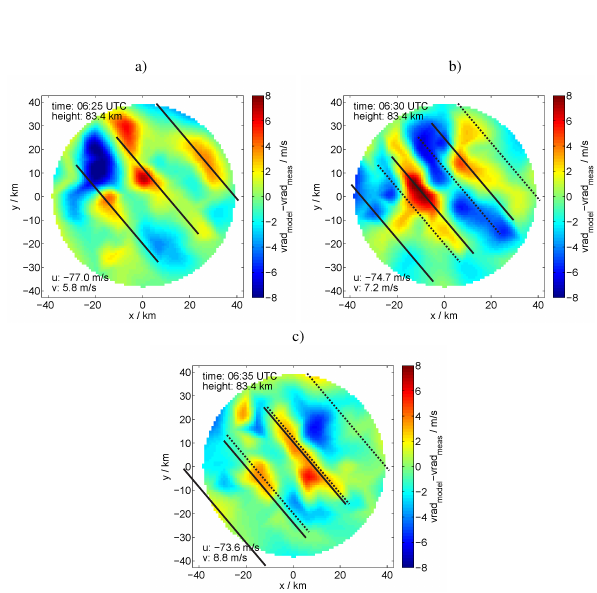
Fig. 11. Remaining horizontally resolved radial wind variation images indicating a dominating monochromatic gravity wave over a period of 15min. This GW event was recorded on 20 July 2011. The black lines indicate the phase lines assuming a monochromatic GW.